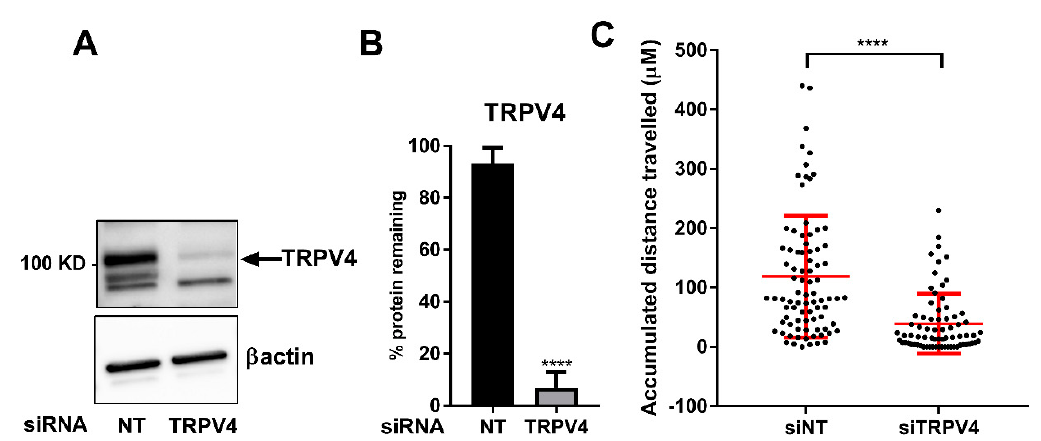
Figure 5. TRPV4 silencing reduces single-cell motility in MDA-MB-468 cells. Immunoblotting studies ( A ) and densitometry analysis ( B ) showing TRPV4 siRNA silencing, reducing TRPV4 protein levels by around 90%. **** p < 0.0001 compared with control (unpaired t -test), n = 3, mean ± SD. ( C ) A collagen-based model and individual cell tracking system were used to assess and quantify the migration of MDA-MB-468 breast cancer cells treated with non-targeting (NT) siRNA (total of 84 cells) and TRPV4 siRNA (total of 72 cells). In this model, the accumulative distance of individual cells migrated over the course of 12 h post-exposure to hypoxia (24 h) is assessed. **** p < 0.0001, (unpaired t -test). Graph represents the mean ± SD for three independent experiments.